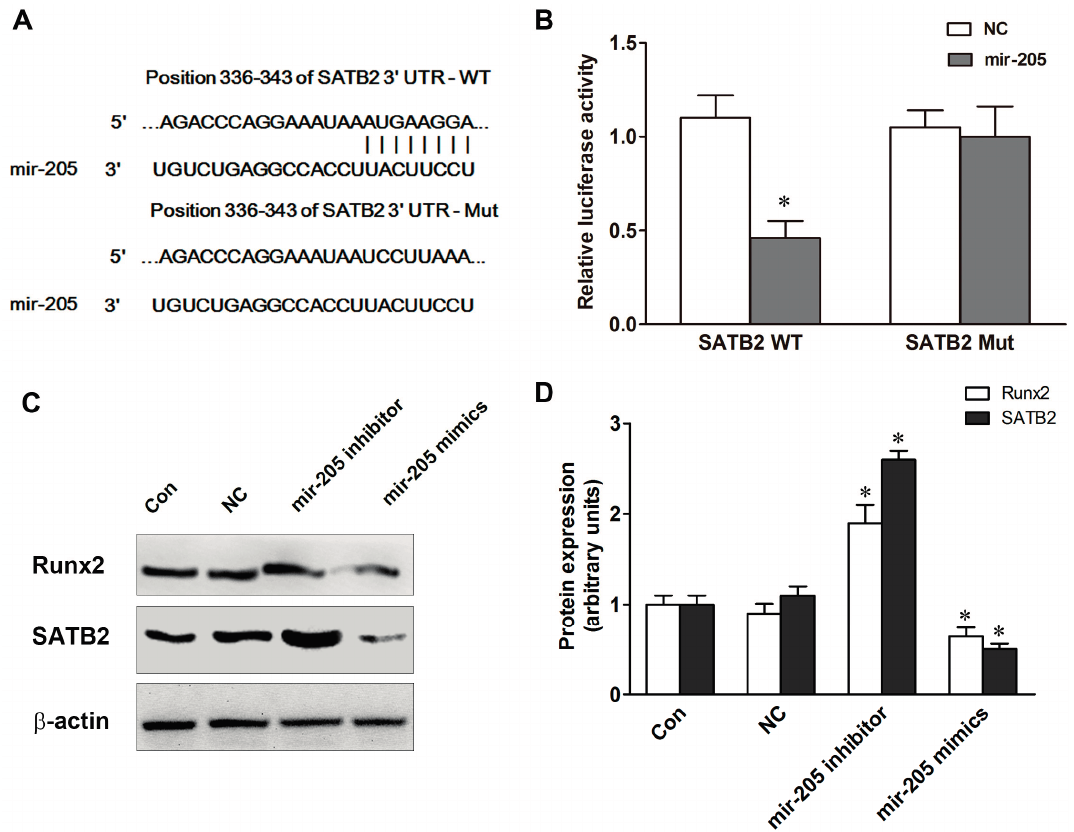
Figure 3. Special AT-rich sequence-binding protein 2 (SATB2) are targets of mir-205. ( A ) Schematic illustration of the predicted miR-205-binding sites in the 3'-untranslated regions (UTRs) of SATB2; ( B ) Luciferase reporter assays. BMSCs were co-transfected with luciferase reporter plasmids containing the wild-type (WT) or mutant (Mut) miR-205 target sites in the SATB2 or NC; ( C , D ) SATB2 and runt-related transcription factor 2 (Runx2) protein expression after treatment with NC, mir-205 inhibitor or mir-205 mimics. Data are depicted as mean ± SD, * p < 0.05 vs.